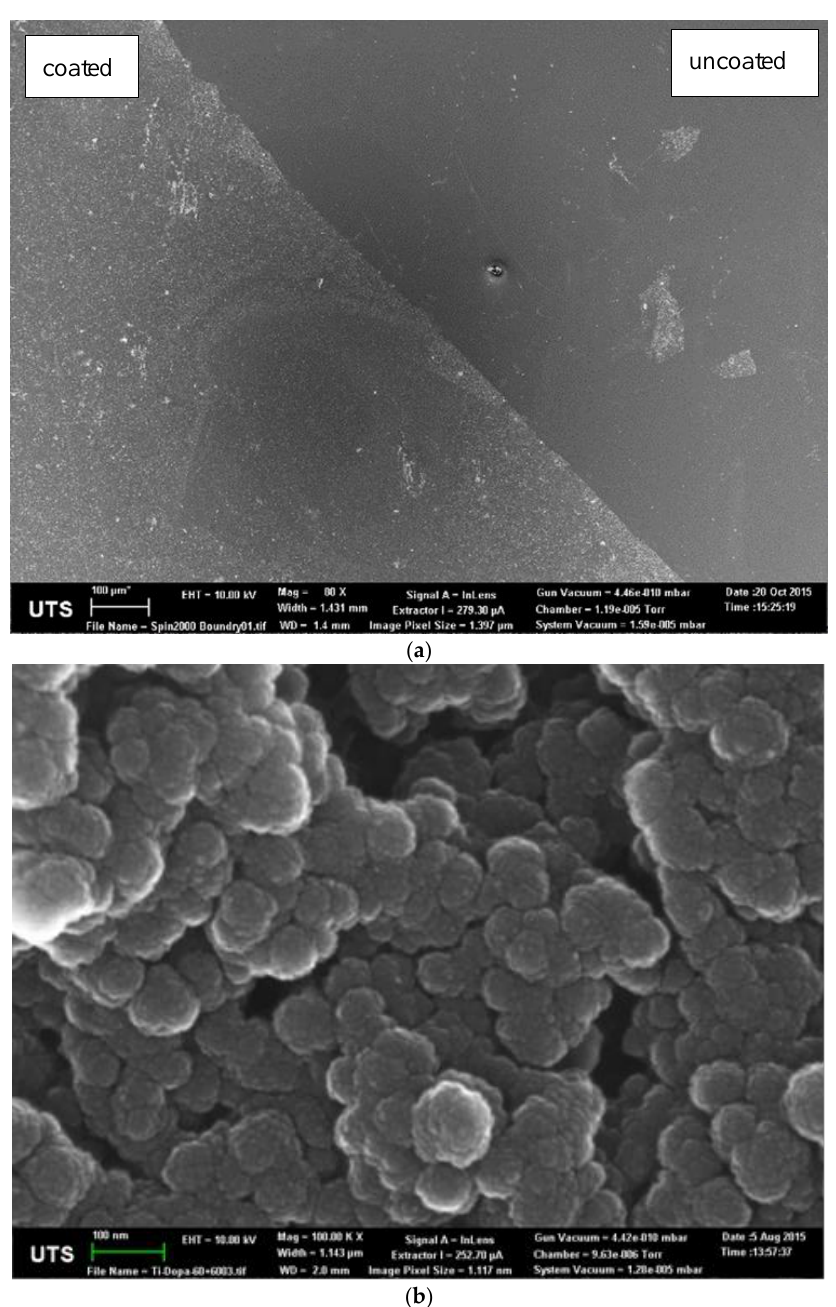
Figure 3. SEM micrographs showing ( a ) the Ti6Al4V surface with a polydopamine (pDA) coating (left) and uncoated (right) at a magnification of 1000×, as well as ( b ) the pDA coating at 100,000× magnification. Table 4. Polydopamine coating thickness as measured by ellipsometry and Atomic Force M.icroscopy (AFM). Time of Immersion